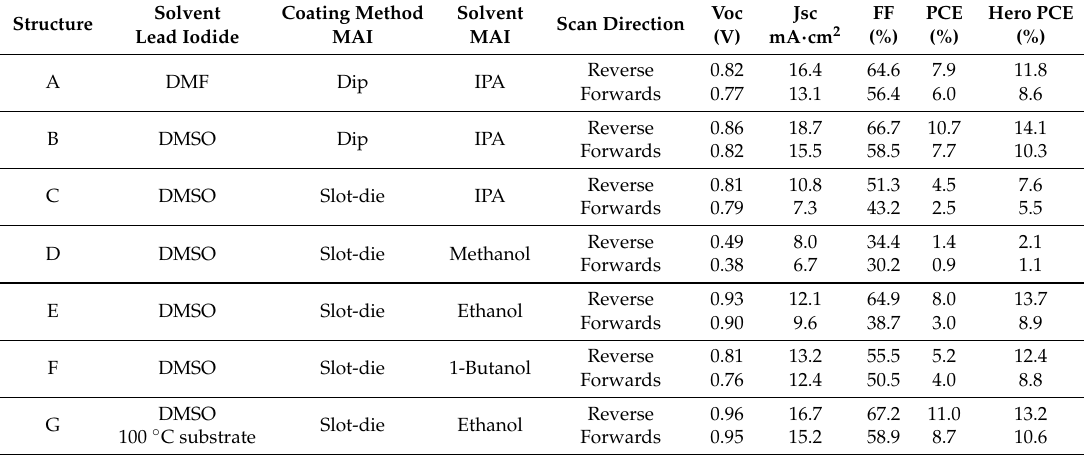
Table 2. Device structures, layer deposition methods and median device performance for 0.09 cm 2 active area